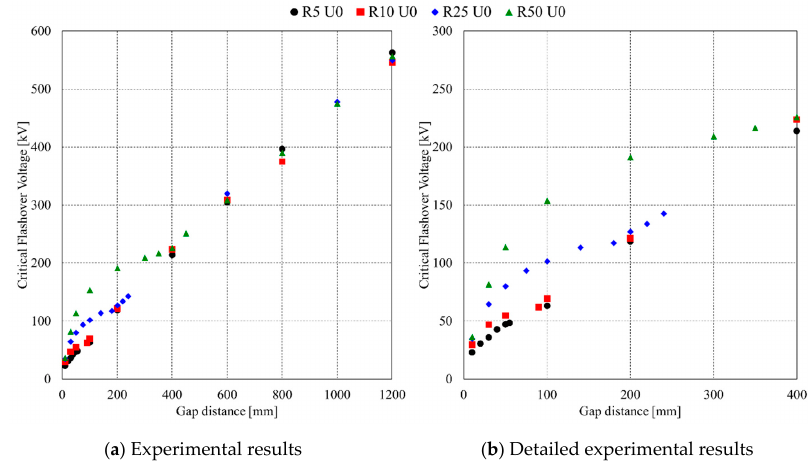
Figure 6. The results of switching impulse critical flashover voltage verification experiment.